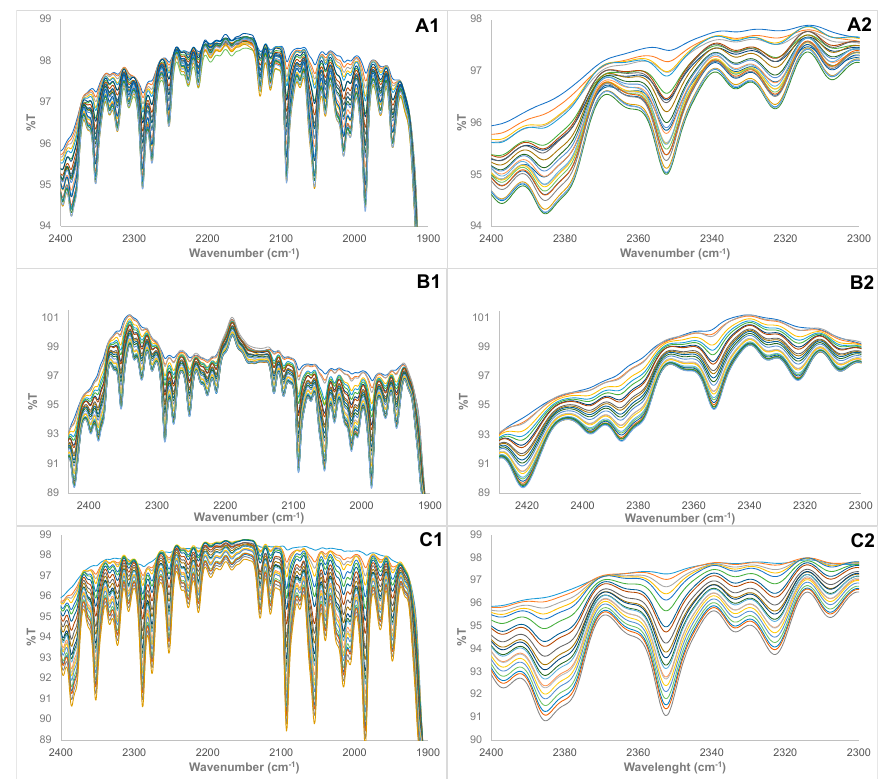
Figure 2. Cross section of FTIR spectra of the training set and calibration samples of: ( A1 , A2 ) highly refined (100%) peanut oil (HRPO) adulterated with vegetable oil, ( B1 , B2 ) HRPO adulterated with canola oil, ( C1 , C2 ) HRPO adulterated with almond oil.